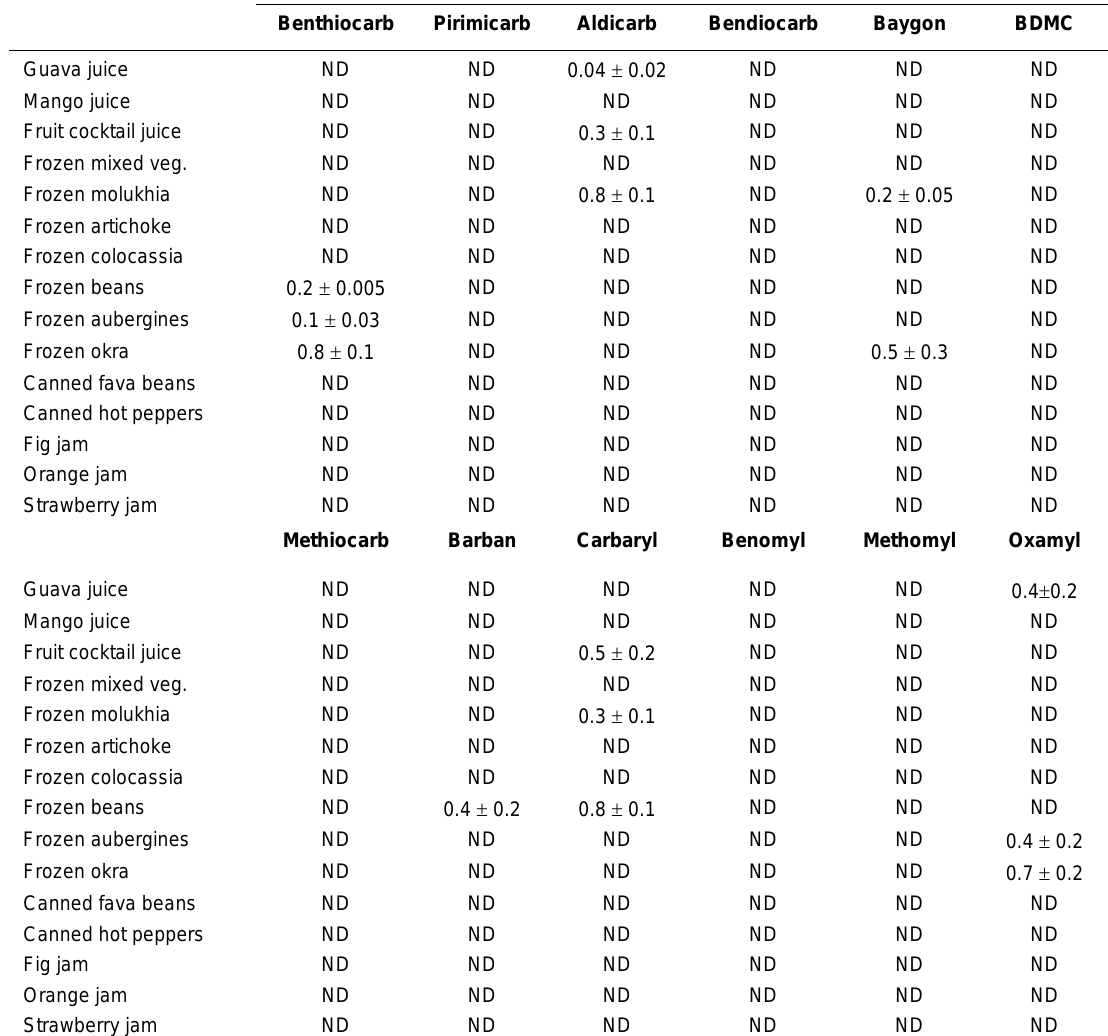
Carbamate Residues (ppm) and RSD in Food Samples Extracted by SFE and Determined by SFC/UVD at 220 nm